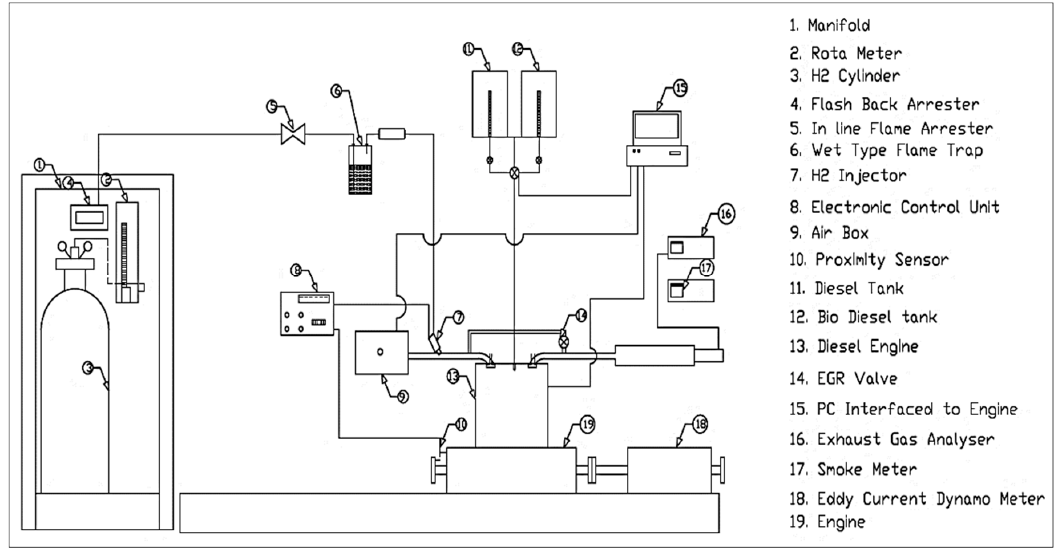
Figure 3. Schematic line diagram for dual fuel mode with hydrogen injection.